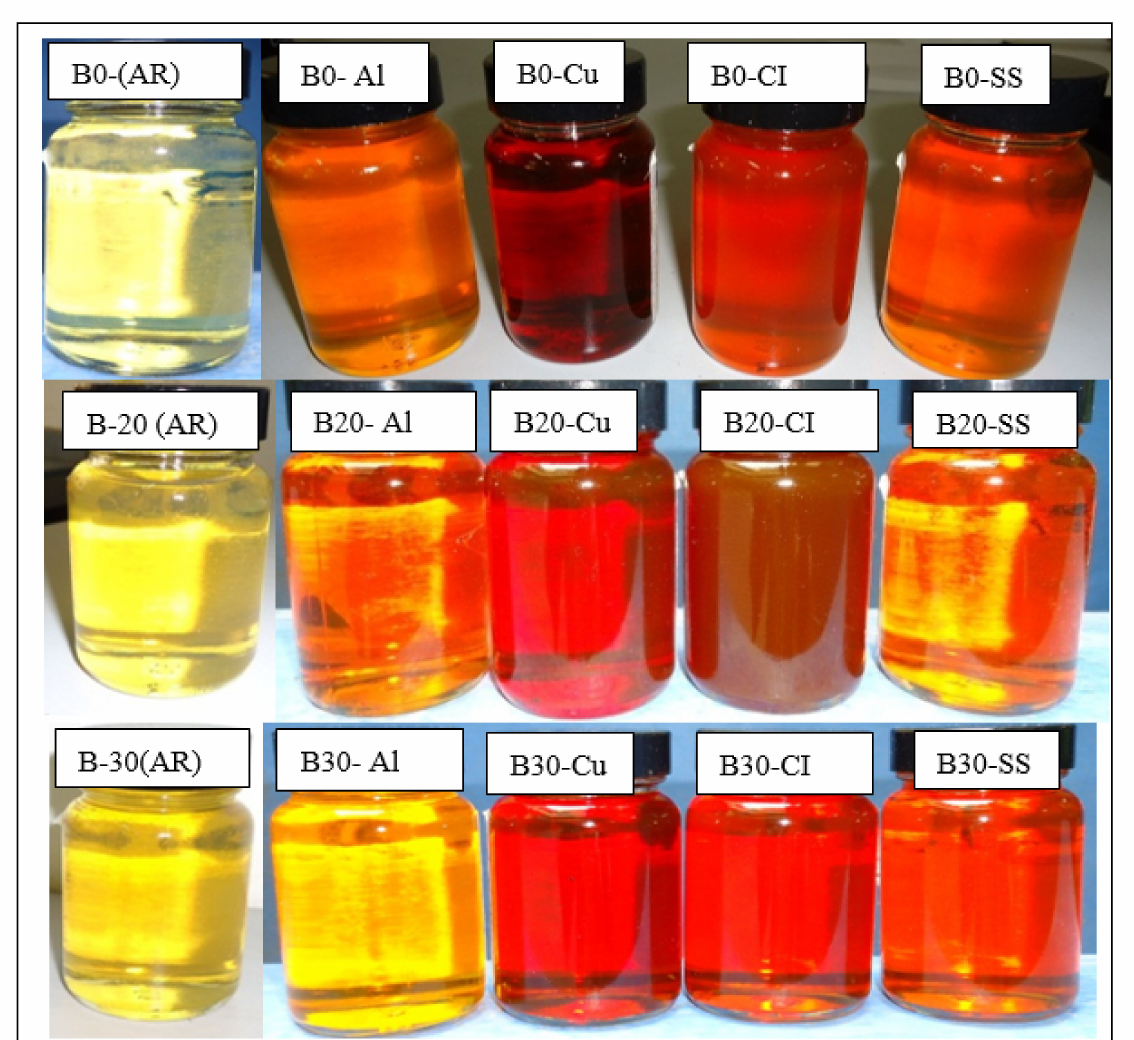
Figure 6. The appearance of biodiesel and diesel after the immersion for 1600